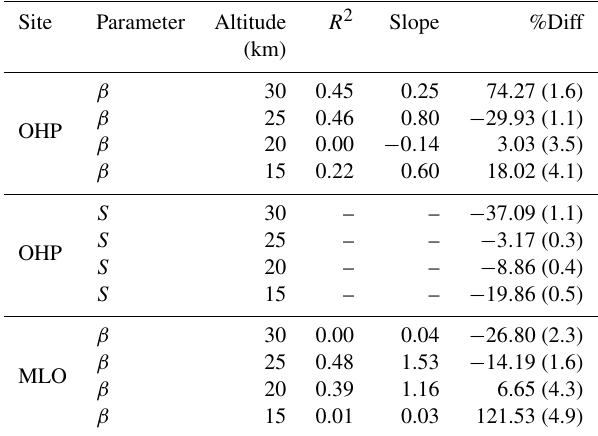
Table 3. Same as Table 2, but for SAGE III. All conditions were classified as